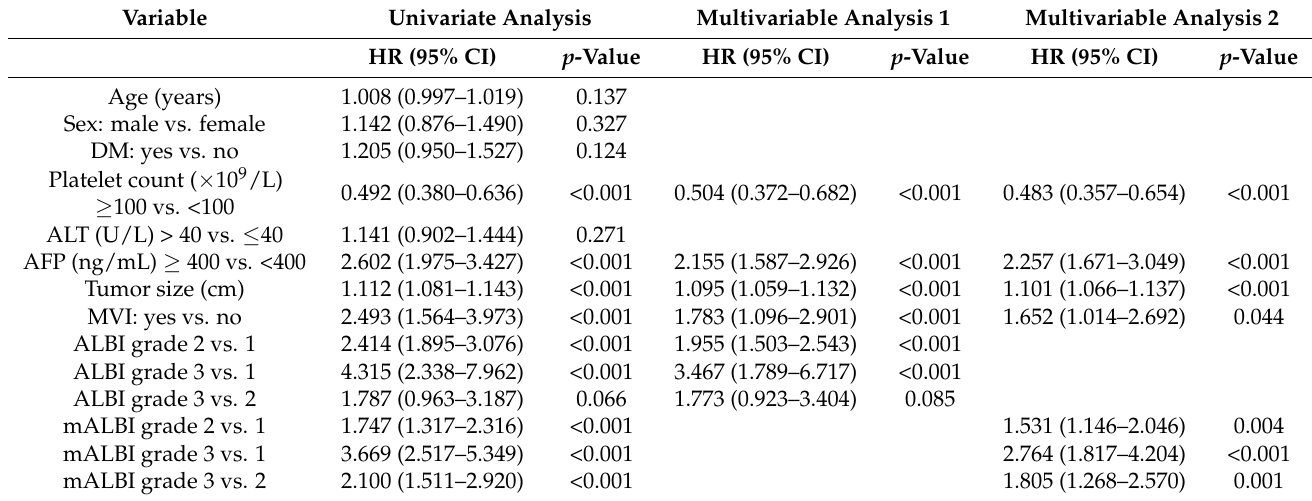
Table 4. Univariate and multivariate Cox regression analyses of the factors associated with the overall survival in patients receiving RFA and surgical